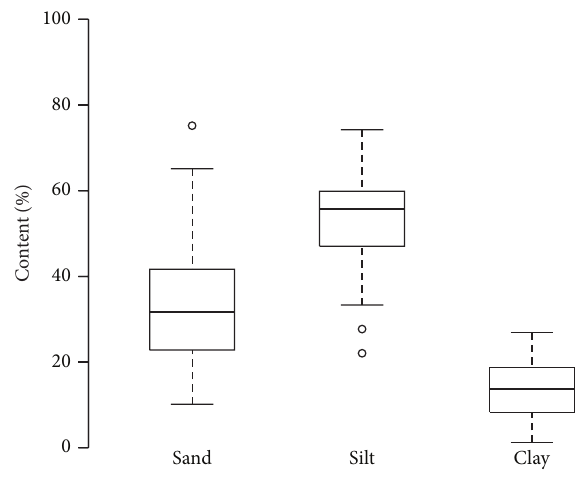
Figure 2: Boxplots of soil